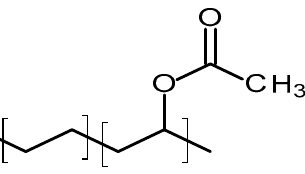
Figure 6. An illustration of the chemical structure of poly(ethylene-vinyl acetate) (PEVA).